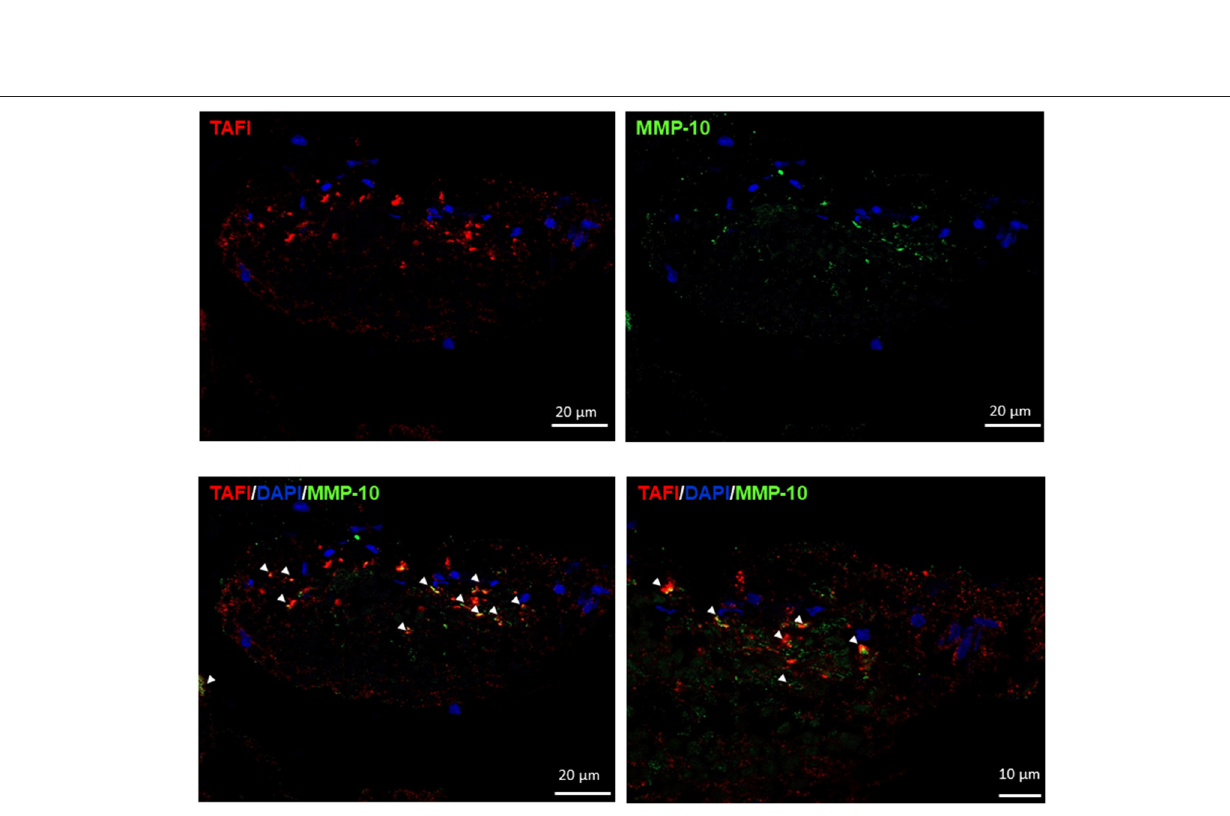
Frontiers in Neurology |